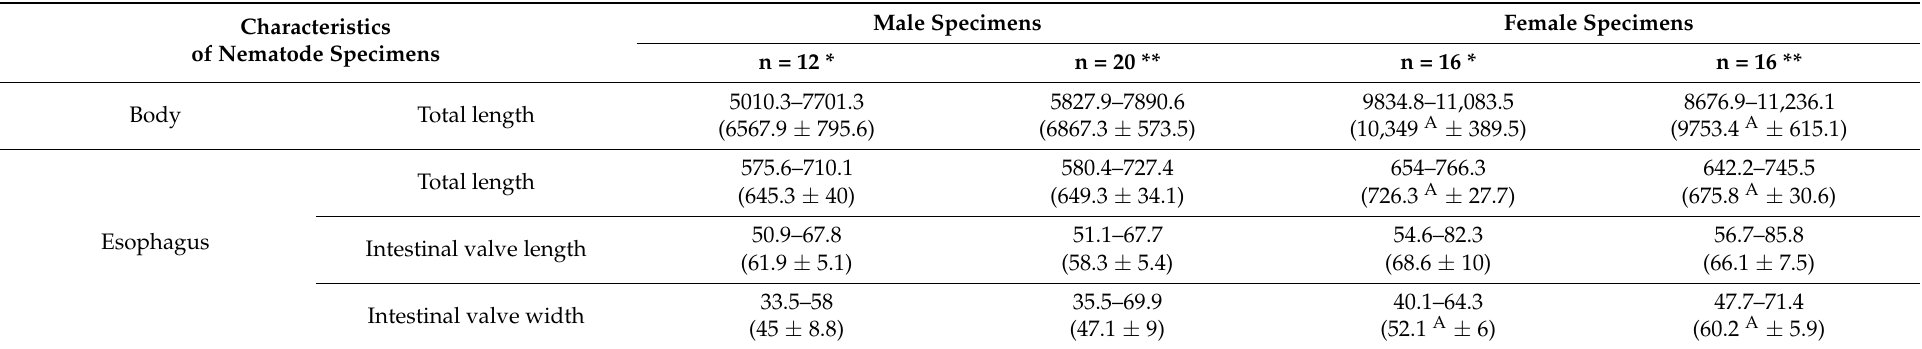
Table 3. Measurements of Ostertagia ostertagi derived from cattle ( Bos taurus )—its principal host (presented in micrometers unless indicated otherwise and given as a range followed by the mean ± SD in parentheses; values in rows with the same letters differ significantly at p <